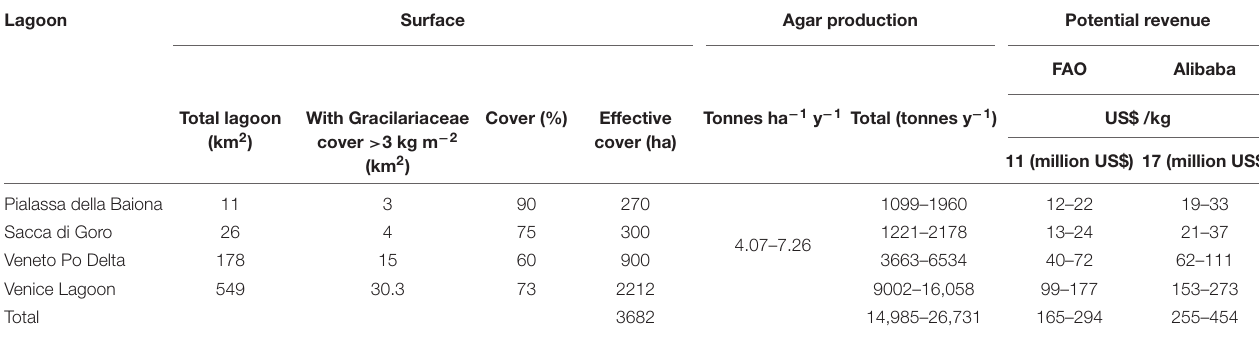
TABLE 5 | Estimate of the potential revenue obtainable from the production of agar in areas with Gracilariaceae biomass > 3 kg m − 2 .